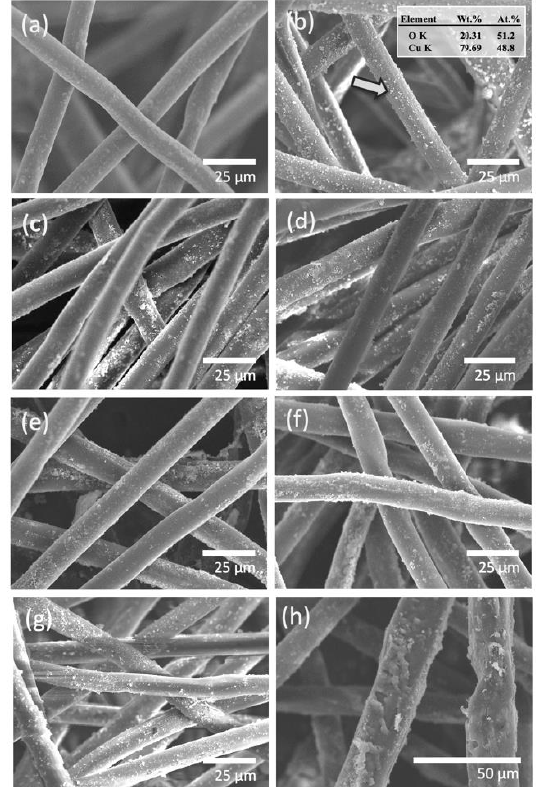
Figure 2. Scanning electron microscopy images of ( a ) Tencel; ( b ) Tecenl+CuO; and Tecenl+CuO+peptide ( c ) 0, ( d ) 30, ( e ) 60, ( f ) 90, and ( g , h ) 120 s of argon plasma treatment time at low and high magnification.